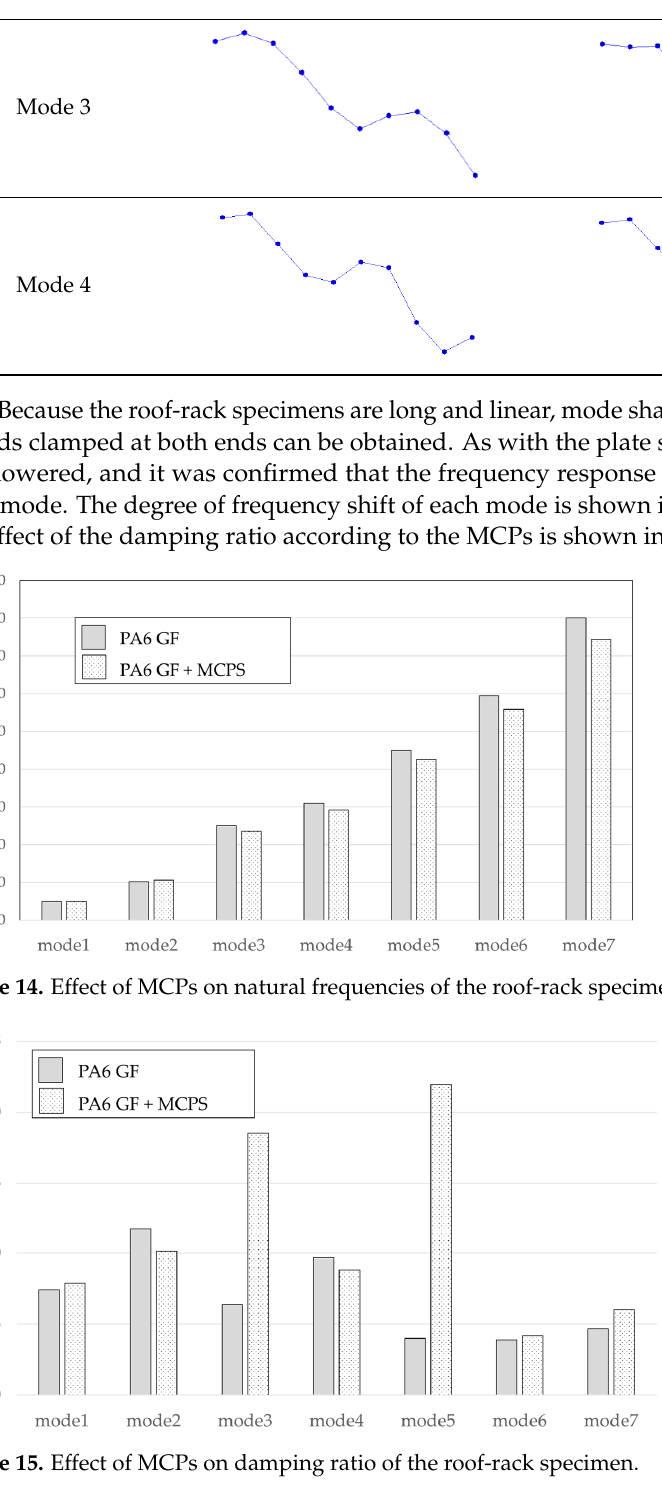
Figure 15. Effect of MCPs on damping ratio of the roof-rack specimen.